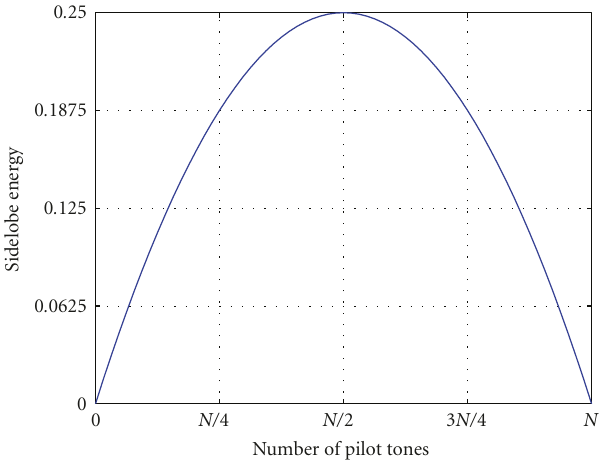
Figure 2: Relation between periodic ACF sidelobe energy and the number of pilot